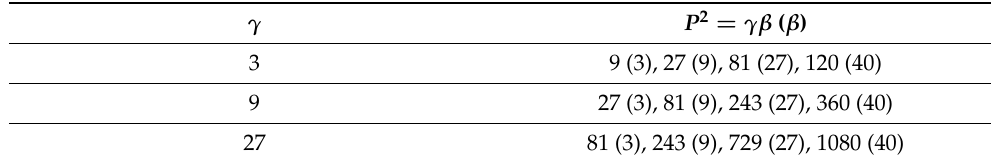
Table 3. The γ and β values taken into account in simulation.